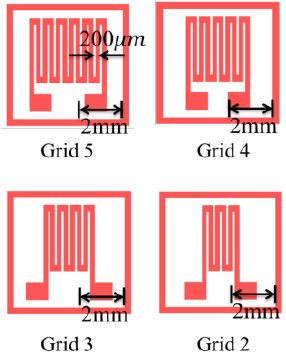
Figure 1. Mask patterns for strain sensor fabrication.